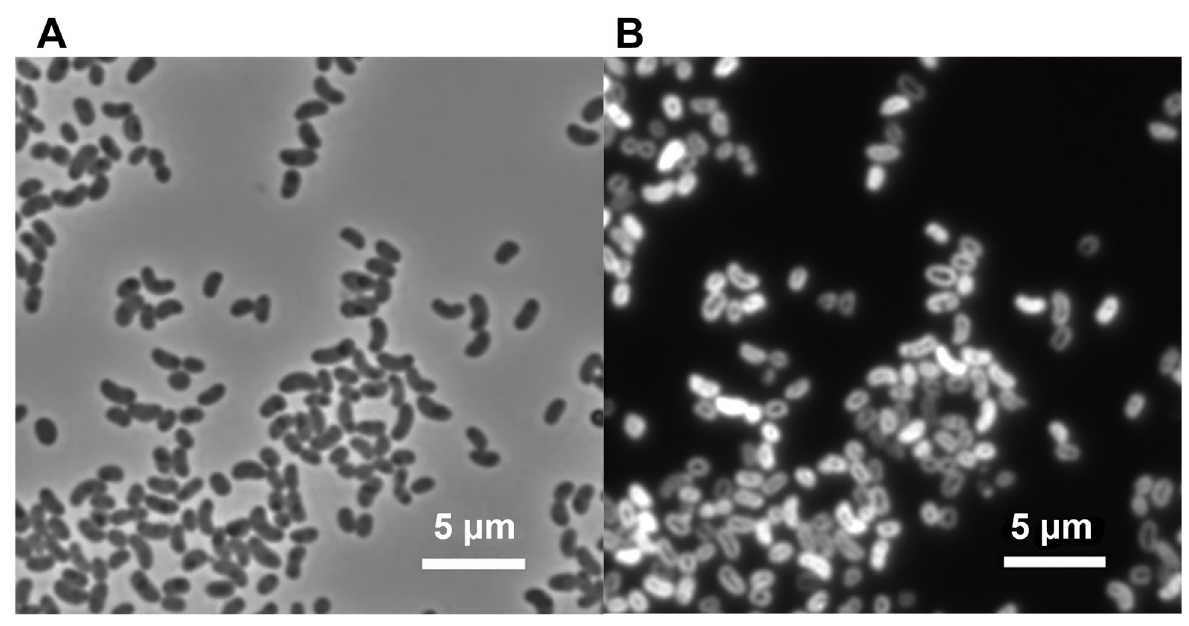
Figure 1. Phase-contrast fluorescence and microscopic images of E. tepida strain MS-P2 T . ( A ) Phase- contrast micrograph of strain MS-P2 T showing curved, vibrio-shaped cells that multiply by binary fission. ( B ) Fluorescence micrograph of the same field as panel ( A ). Scale bars = 5 μ m.